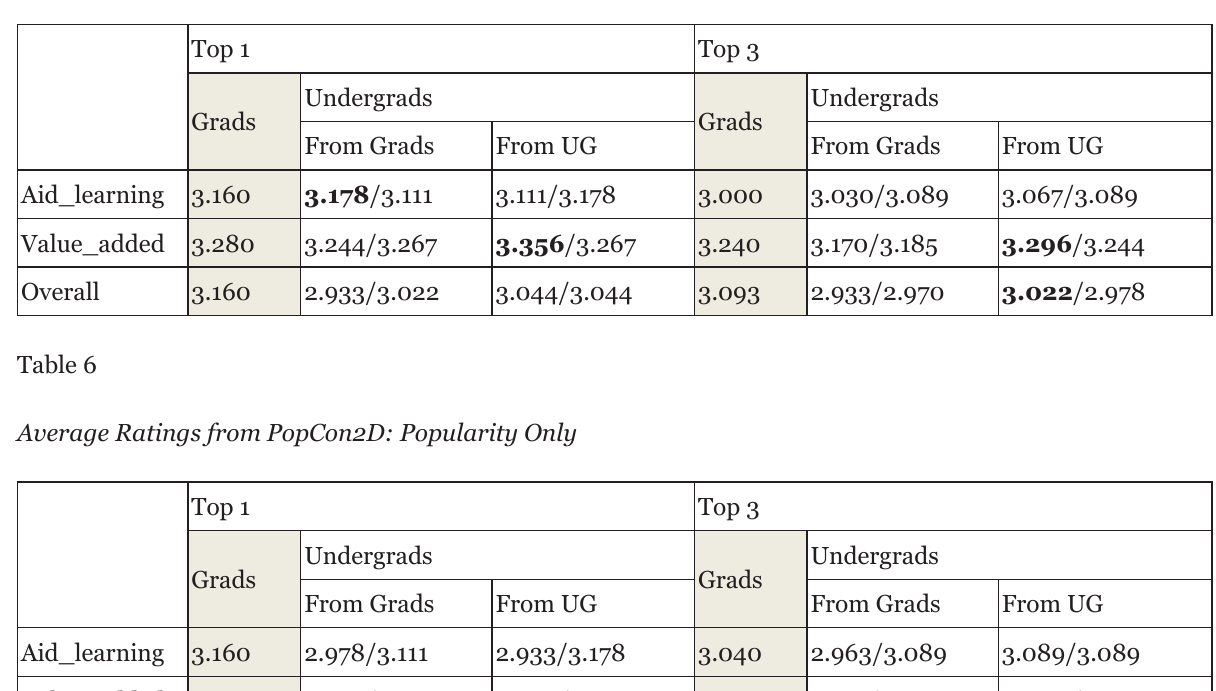
Average Ratings from PopUM-CF: Popularity Only